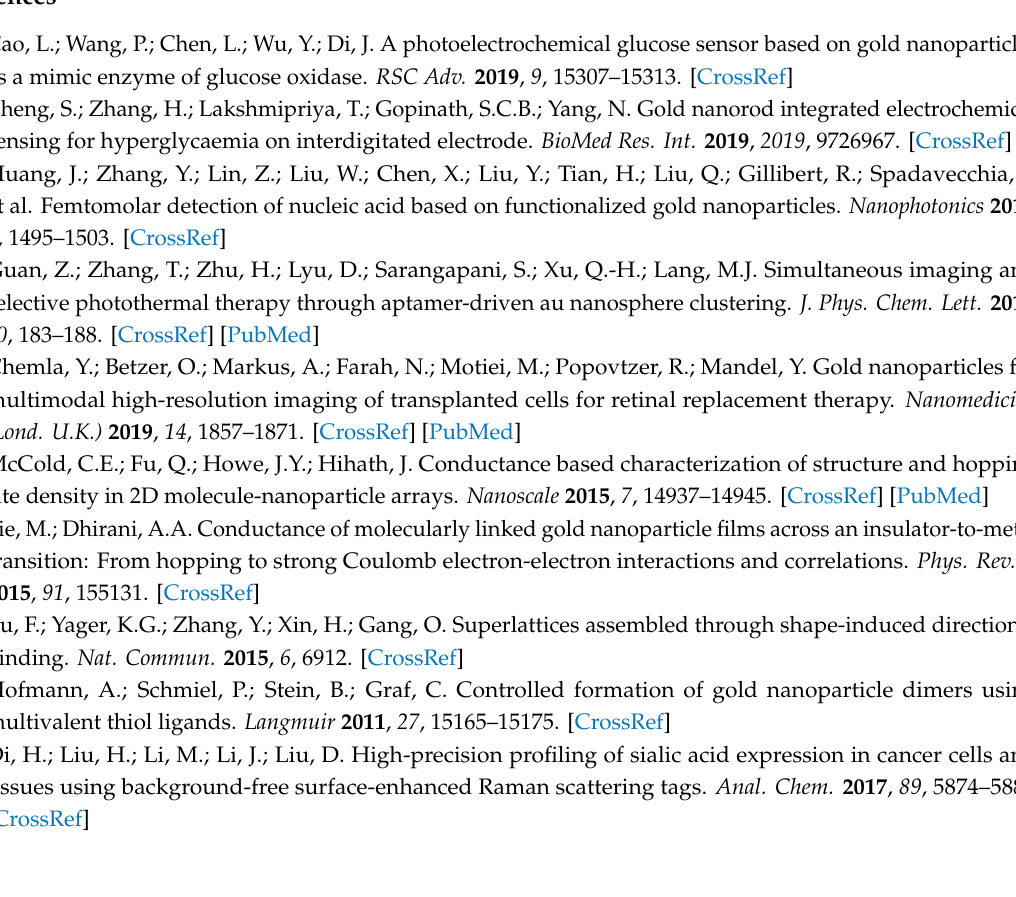
Figure S1 UV-vis spectrum and analysis of AuNPs, Figure S2: XRD patterns of the samples S30 and S30 / 20 , Figure S3: Reflectance spectrum of Al mirror, Figure S4: SEM images of control